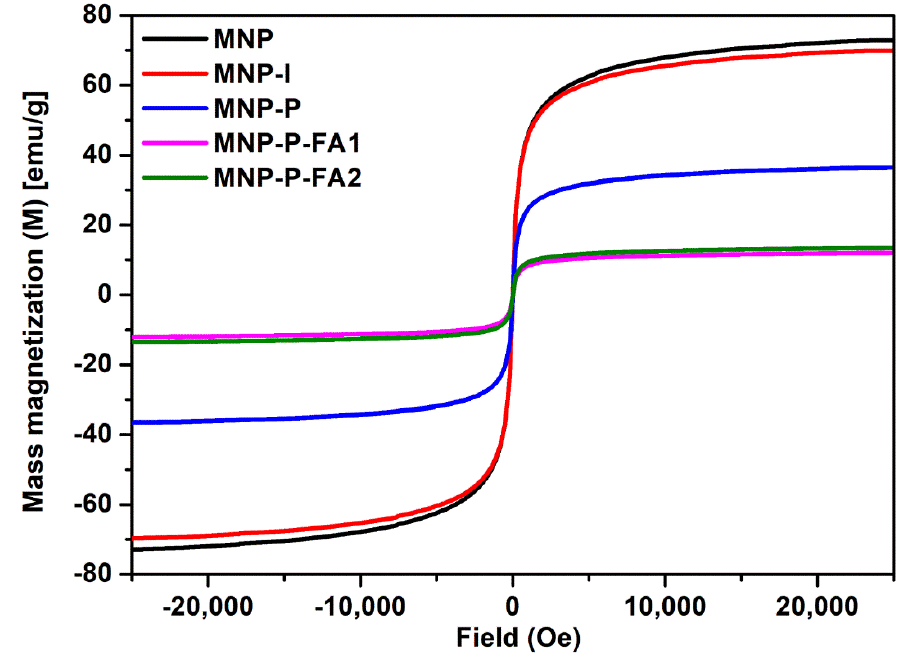
Figure 6. VSM magnetization at 2.5 T of MNP (black), MNP-I (red), MNP-P (blue), MNP-P-FA1 (magenta) and MNP-P-FA2 (green).